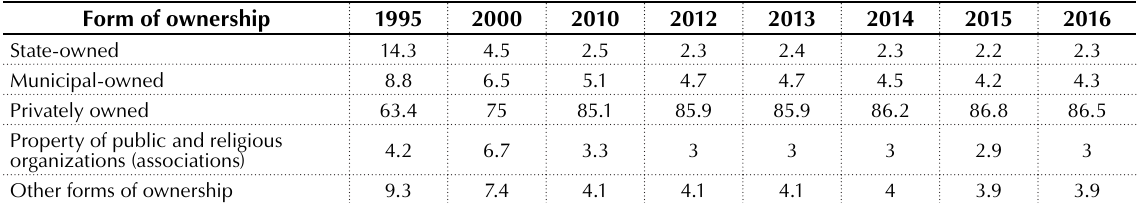
Table 3. Distribution of enterprises and organizations by forms of ownership (in %) Source: Compiled according to the data from the Russian Statistical Yearbook (2016).